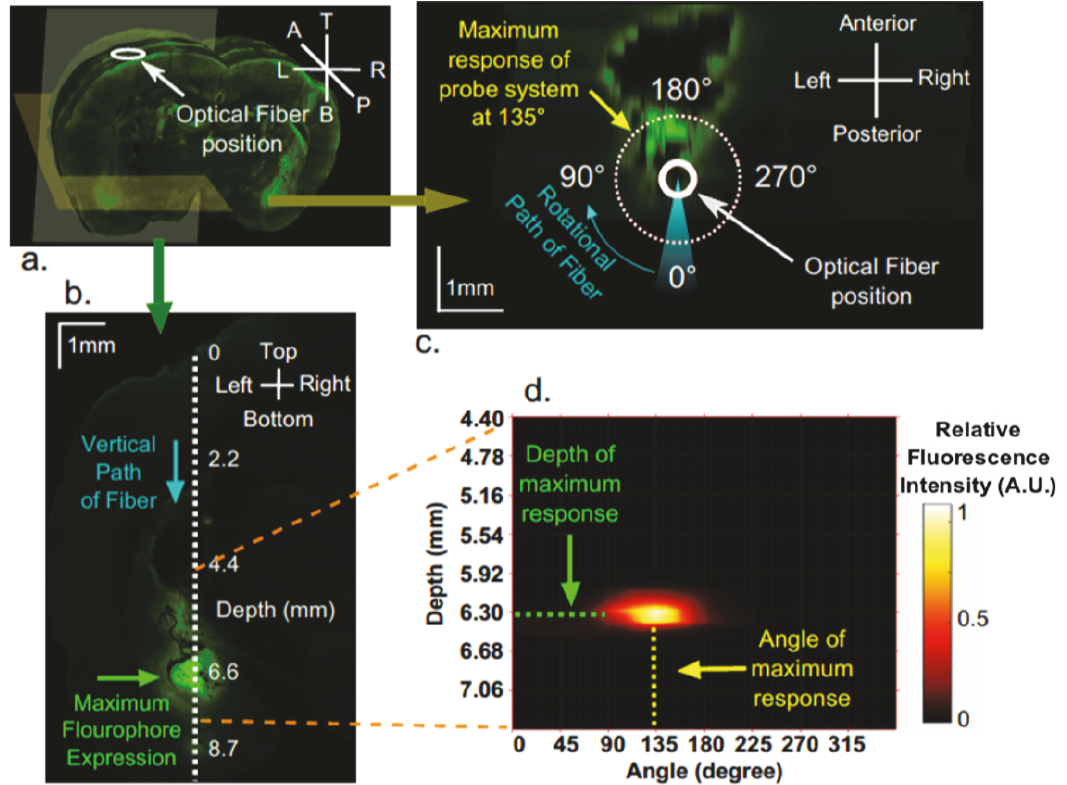
Figure 9: (a) In vivo results. 3D image reconstruction of a section of the brain under test. (b) Following the path of the fiber, the maximum expression is found at approximate depth of 6.6 mm from the surface. (c) Following the rotational path of the fiber, we found the maximum expression closest to the fiber tip at approximately 135 ∘ . (d) Data collected with our system and presented using gamma correction factor of